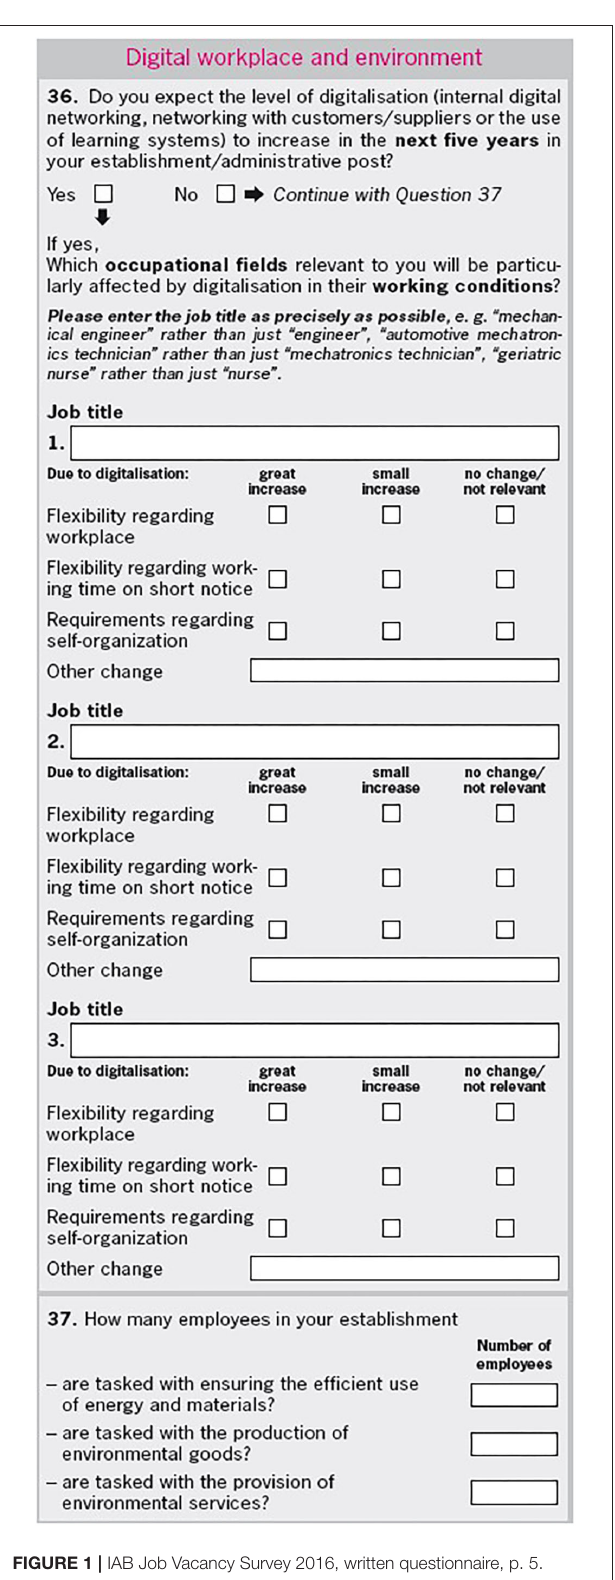
FIGURE 1 | IAB Job Vacancy Survey 2016, written questionnaire, p. 5.